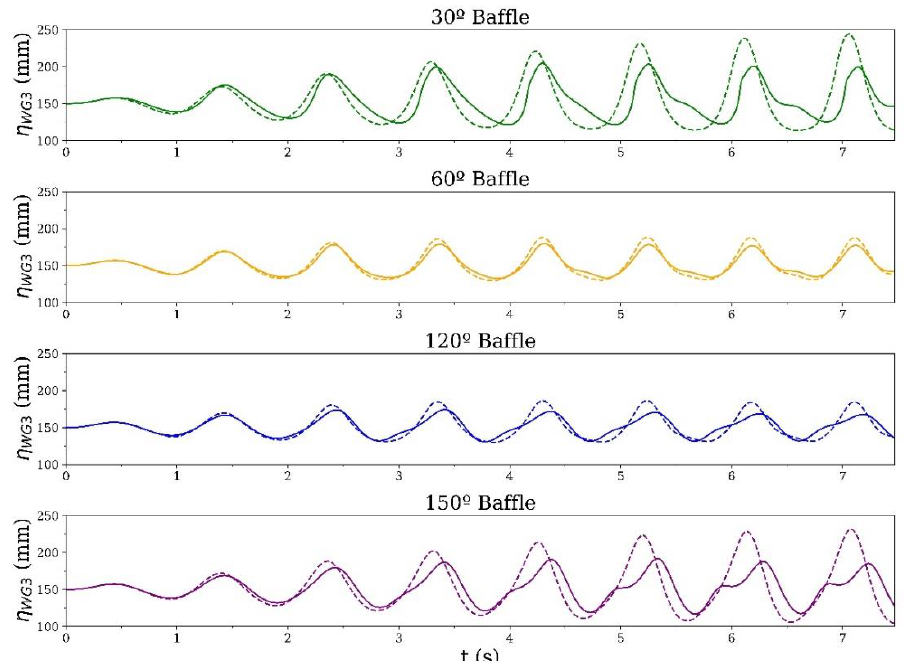
Figure 5. Free surface elevation at WG3. The solid line represents the simulations where H b = 75 mm, the dotted line where L b = 75 mm.